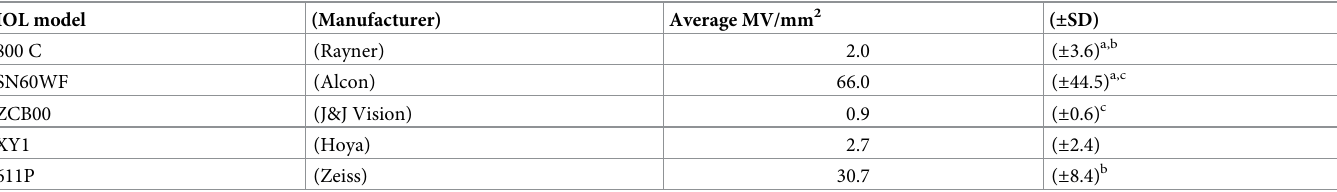
Table 2. Glistening